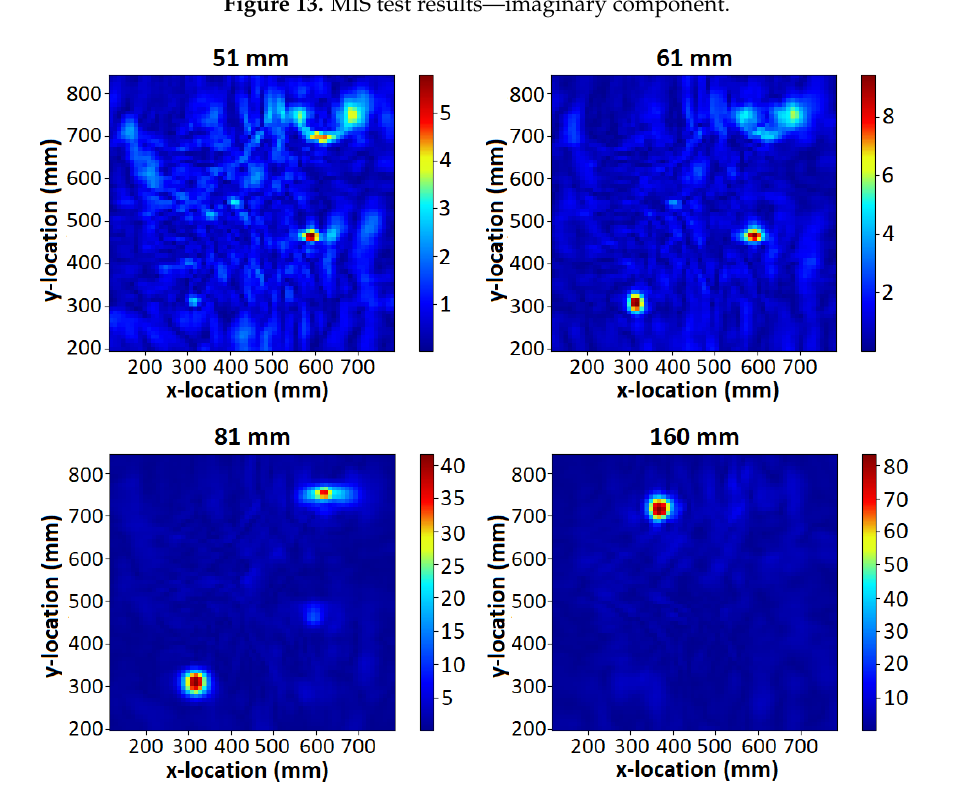
Figure 14. GPR testing